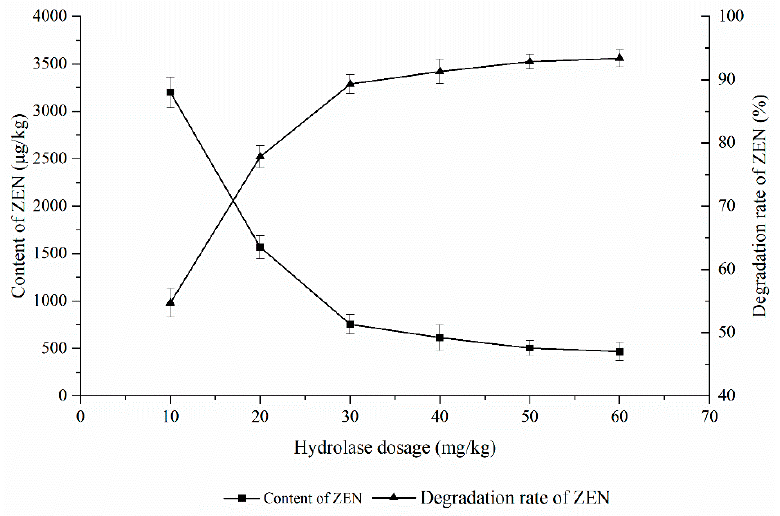
Figure 4. Effects of enzyme dosage on the degradation of zearalenone.